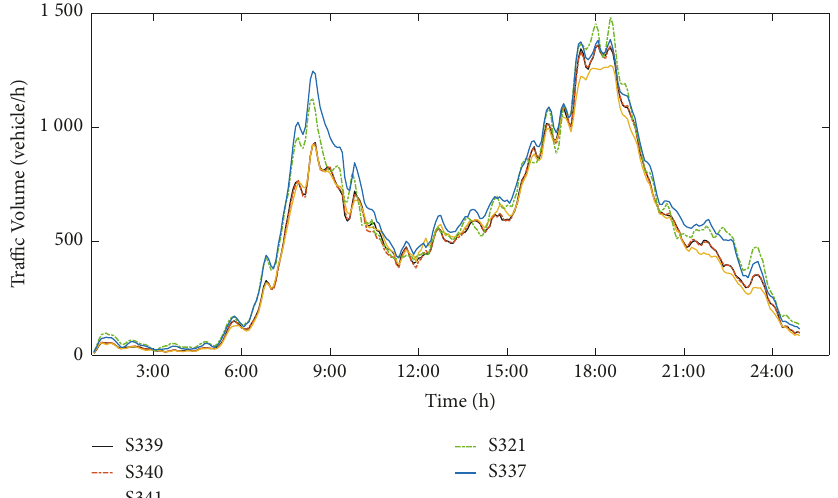
Figure 5: Traffic flows in the station S339 and 4 neighboring stations.